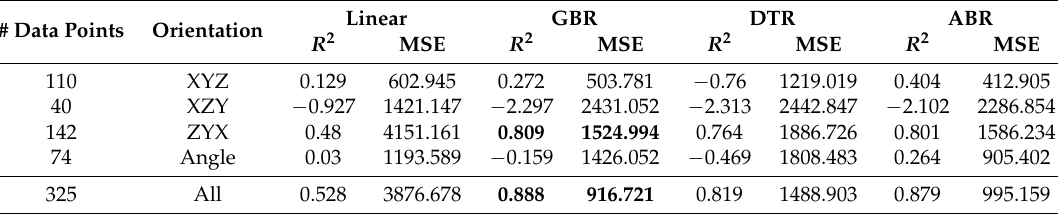
Table 5. Prediction of Tensile Modulus with the help of machine learning techniques. Linear means linear regression models, GBR stands for Gradient Boost Regressor, DTR for Decision Tree Regressor, and ABR for AdaBoost Regressor.